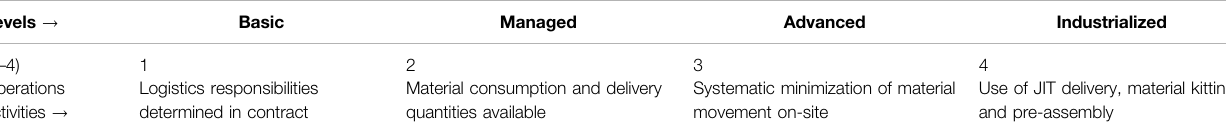
TABLE 7 | Operations maturity.